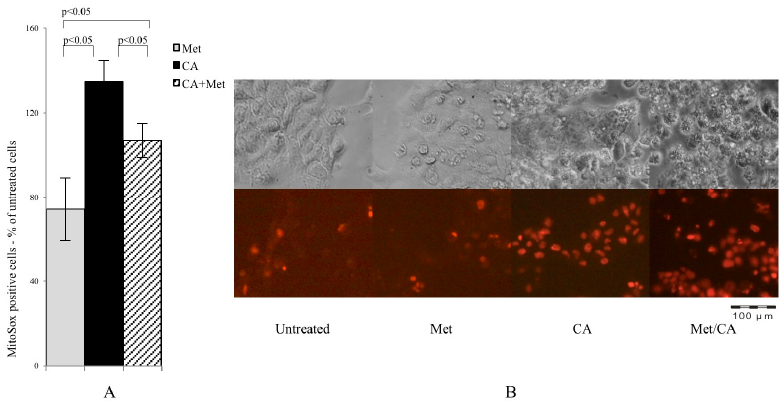
Figure 3. CA and Met/CA causes significantly enhanced generation of mitochondrial ROS measured with MitoSox Red probe by flow cytometry ( A ) and visualized by fluorescence microscopy after incubation of HTB-34 cells with Met at 10 mM and CA at 100 µM for 24 h; ( B ) note the induction of mitochondrial oxidative stress after incubation of cells with CA and Met/CA (red fluorescence indicate mitochondrial superoxide). Experiments were repeated three times with similar results.